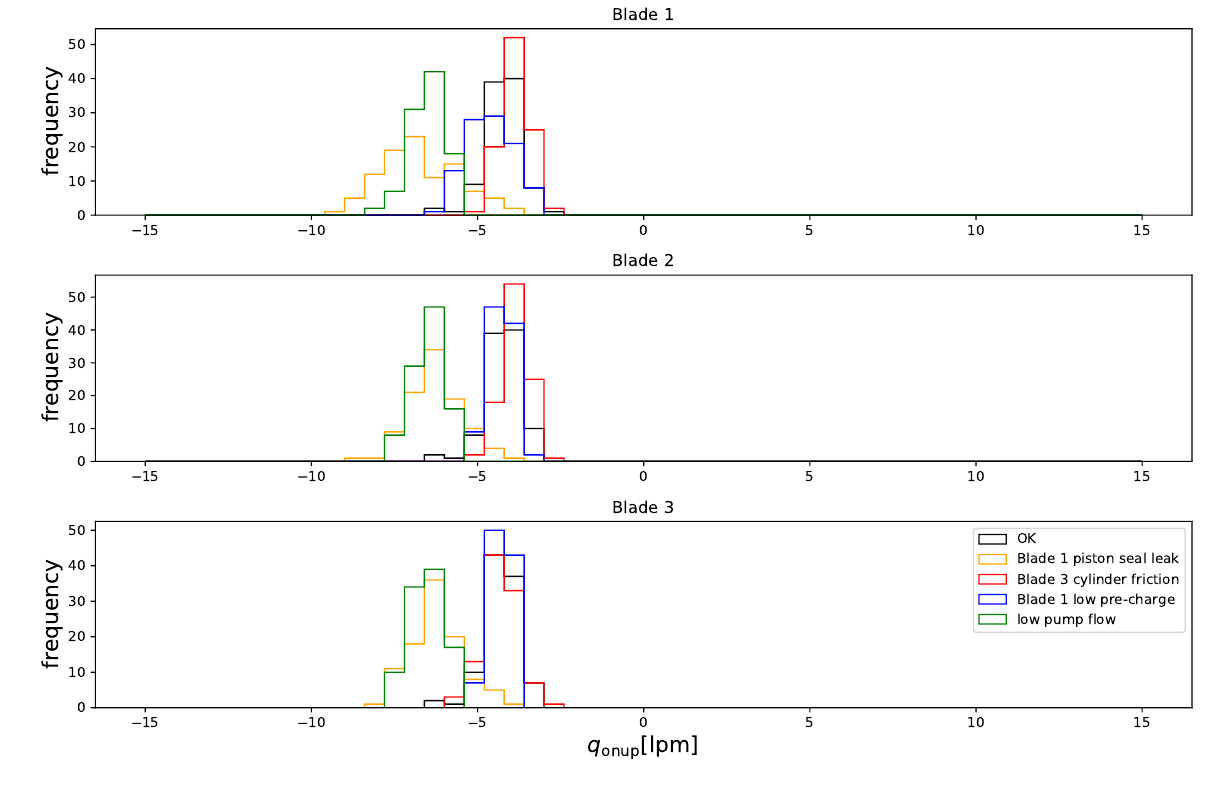
Figure 18. Simulation parameter distribution, q onup .